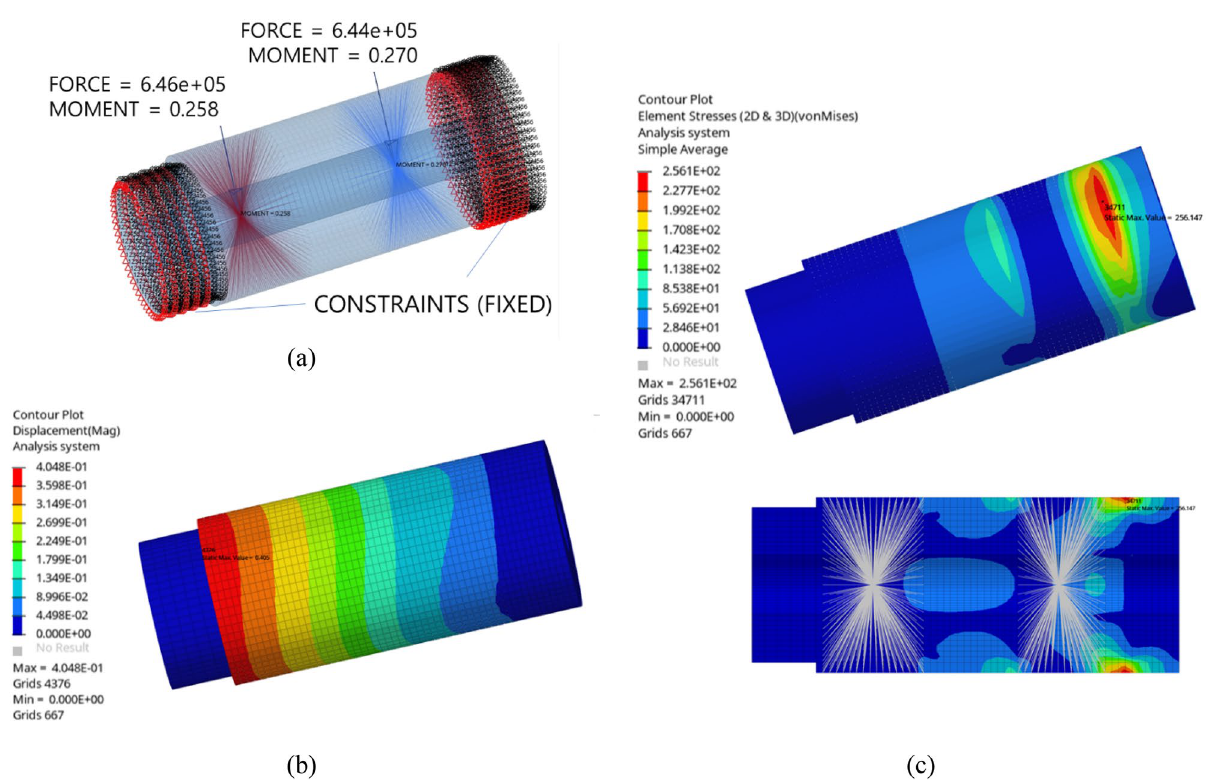
Figure 3. Finite element analysis and results of the original model: ( a ) boundary conditions and constraints (in kN and Nm), ( b ) displacement (in mm), and ( c ) von Mises stress (in